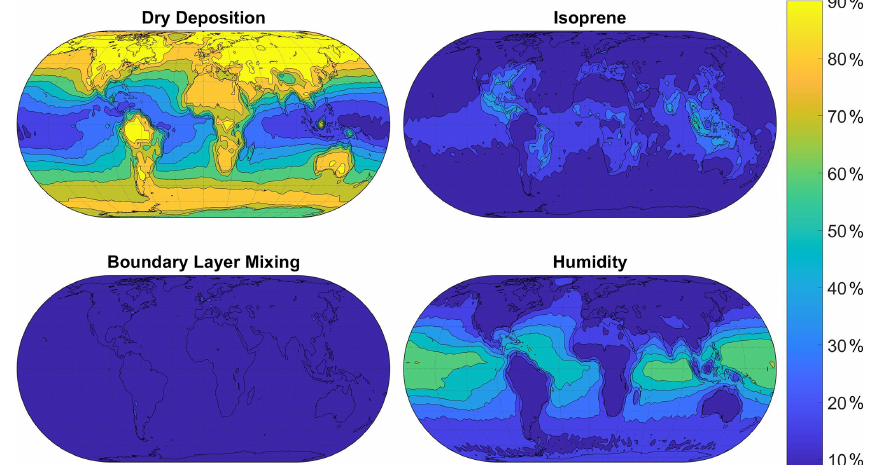
Figure 5. Sensitivity indices representing the percentage of the variance in surface O 3 in the FRSGC/UCI model output due to changes in each input parameter. The four parameters displayed here have the highest sensitivity indices and the largest effect on simulated surface O 3 . Maps of sensitivity indices corresponding to the other four parameters are shown in Fig. S2 of the Supplement.